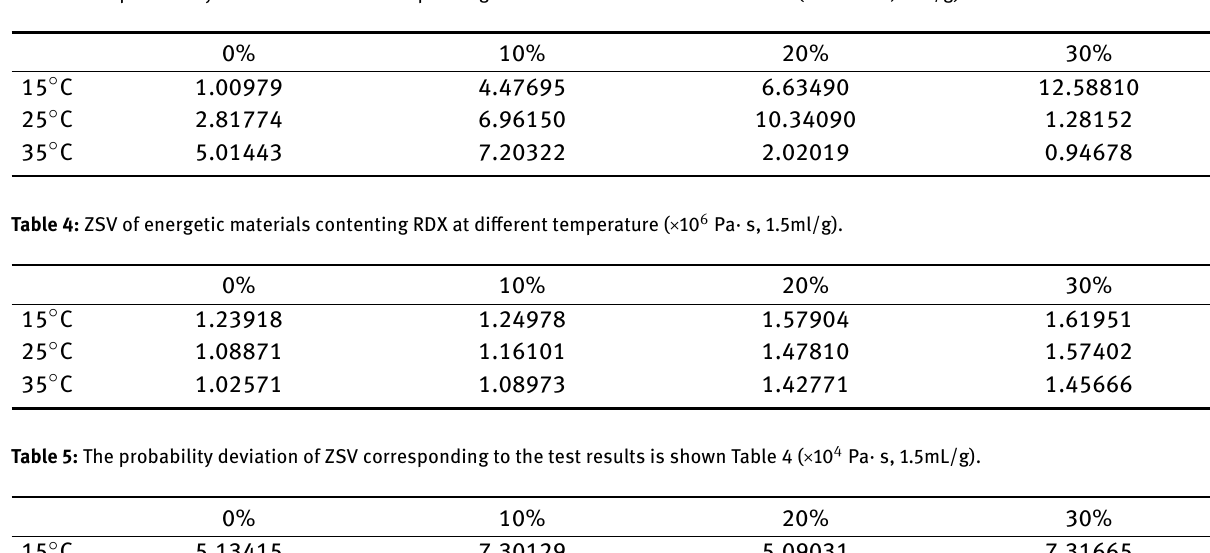
Table 3: The probability deviation of ZSV corresponding to the test results is shown Table 2 ( × 10 4 Pa · s, 1mL/g).